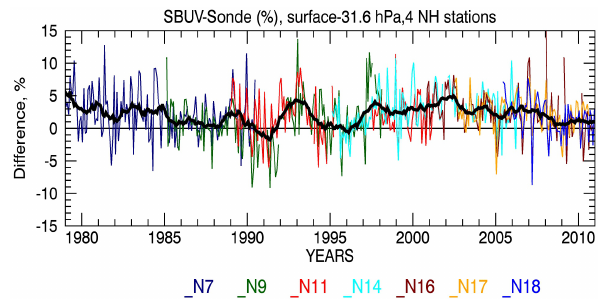
Fig. 11. Same as Fig. 10 but for the difference with the ensemble of four northern midlatitude sonde stations. The ensemble includes sonde data from Lindenberg (52 ◦ N), Hohenpeissenberg (48 ◦ N), Boulder (40 ◦ N) and Payerne (47 ◦